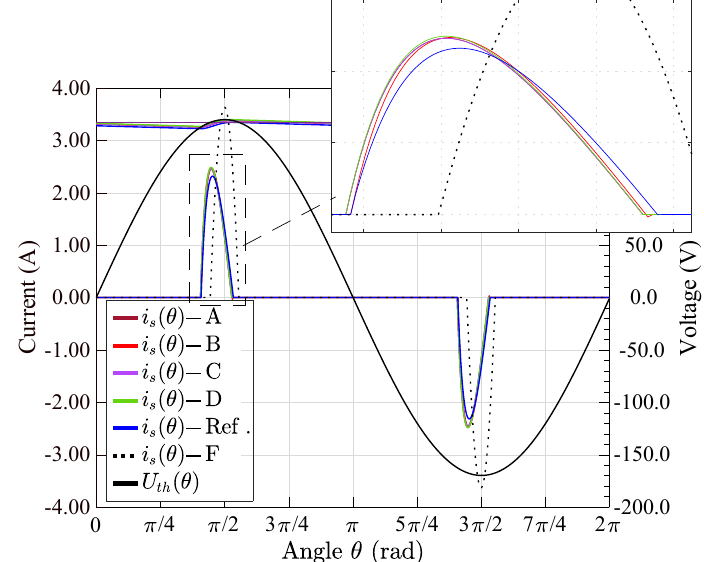
Figure 2. Voltage and current waveforms obtained from different models and numerical solution for sinusoidal voltage and resistive source.